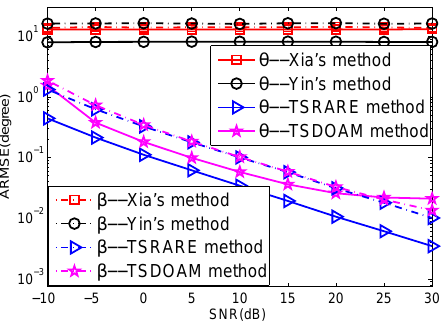
Figure 3. The average root mean square error (ARMSE) versus signal-to-noise ratio (SNR). TSDOAM: two-stage direction-of-arrival